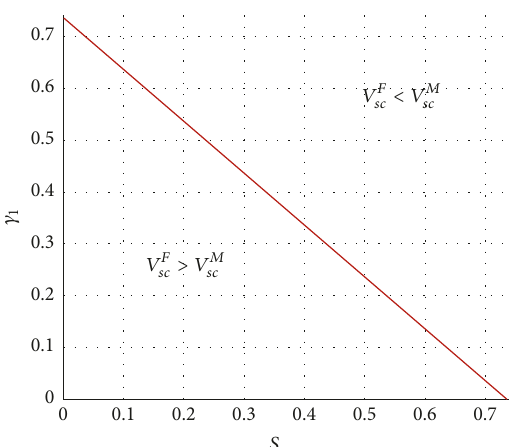
Figure 4: The comparison of the whole supply chain’s profits in terms of 𝛾 1 and 𝑆